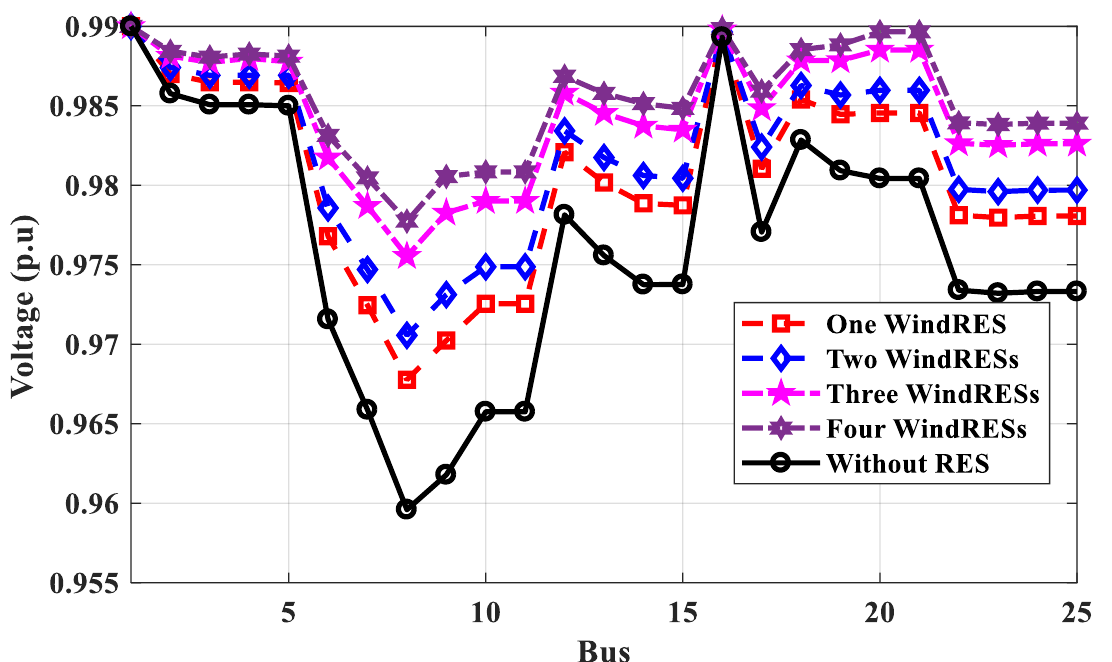
Figure 21. Voltage profile of 25-bus 500 kV EPS without and with wind systems for annual energy loss calculation.